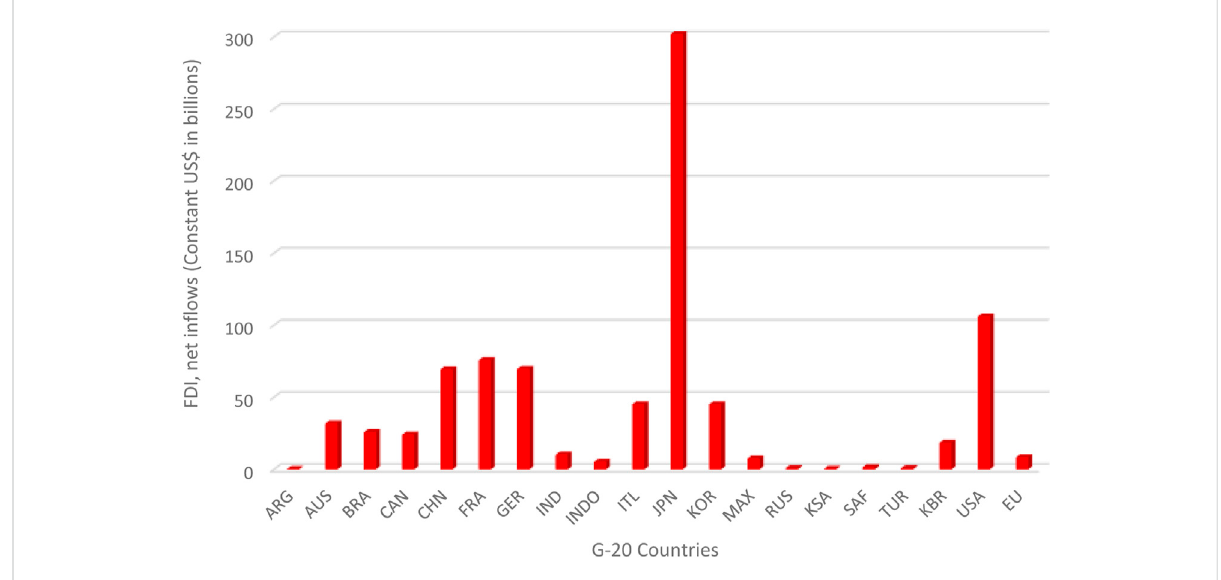
FIGURE 4 FDI, net in fl ows (Constant US$ in billions) of G-20 based on 2018. (Note: The data of FDI, net in fl ows (Current US$ in billions) for each country were converted into constant values by dividing it from GDP de fl ator).